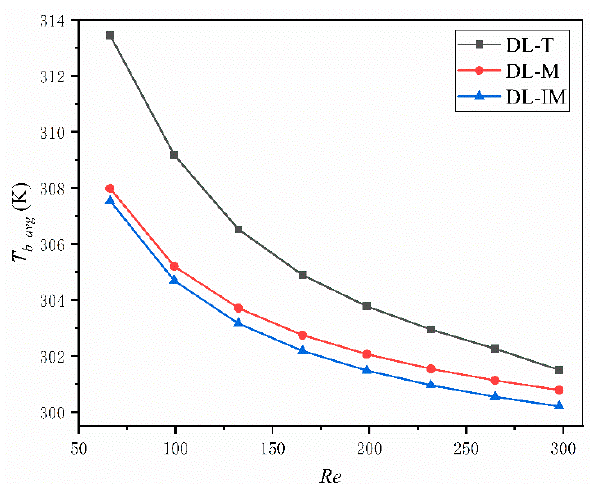
Figure 8. Maximum temperature on the base surface of DL-T, DL-M and DL-IM structure in different Reynolds number conditions.